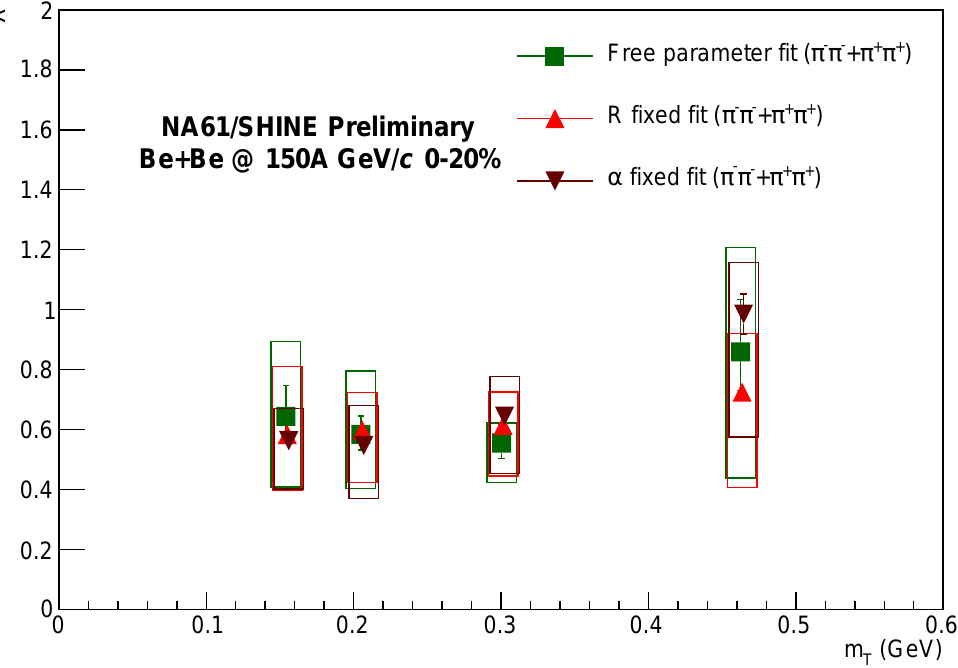
Figure 4. Lévy exponent λ versus transverse mass: comparison between free parameter fit, fit with α fixed and fit with R fixed. The boxes represent systematic uncertainties. For each bin, the results are slightly shifted to the right for visibility, but they are in the same